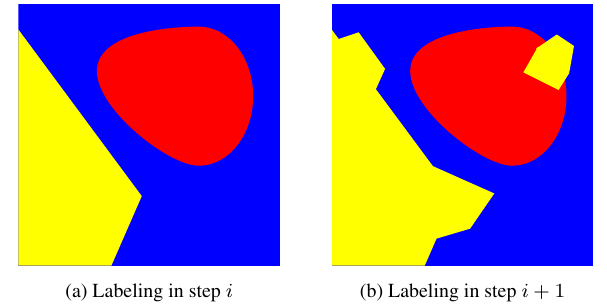
Figure 2. Example of a step of the expansion-move algorithm. In this example we have 3 labels; on the left, the labeling obtained in step i is shown and on the right, the labeling for step i + 1 is shown after performing an expansion-move step of the label represented by the color yellow.